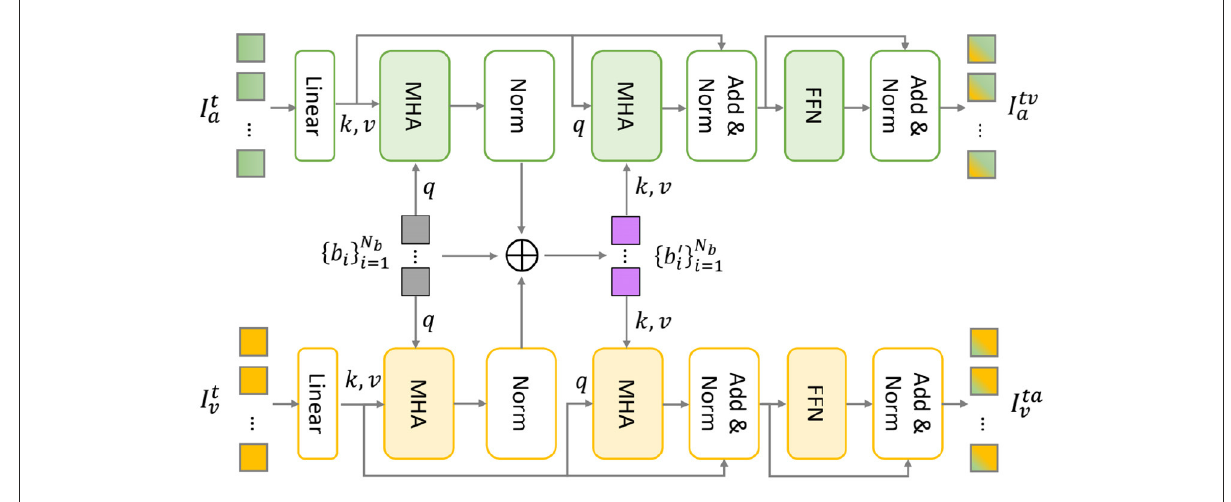
FIGURE3 The multimodal bottleneck transformer (MBT) architecture (Liu et al.,